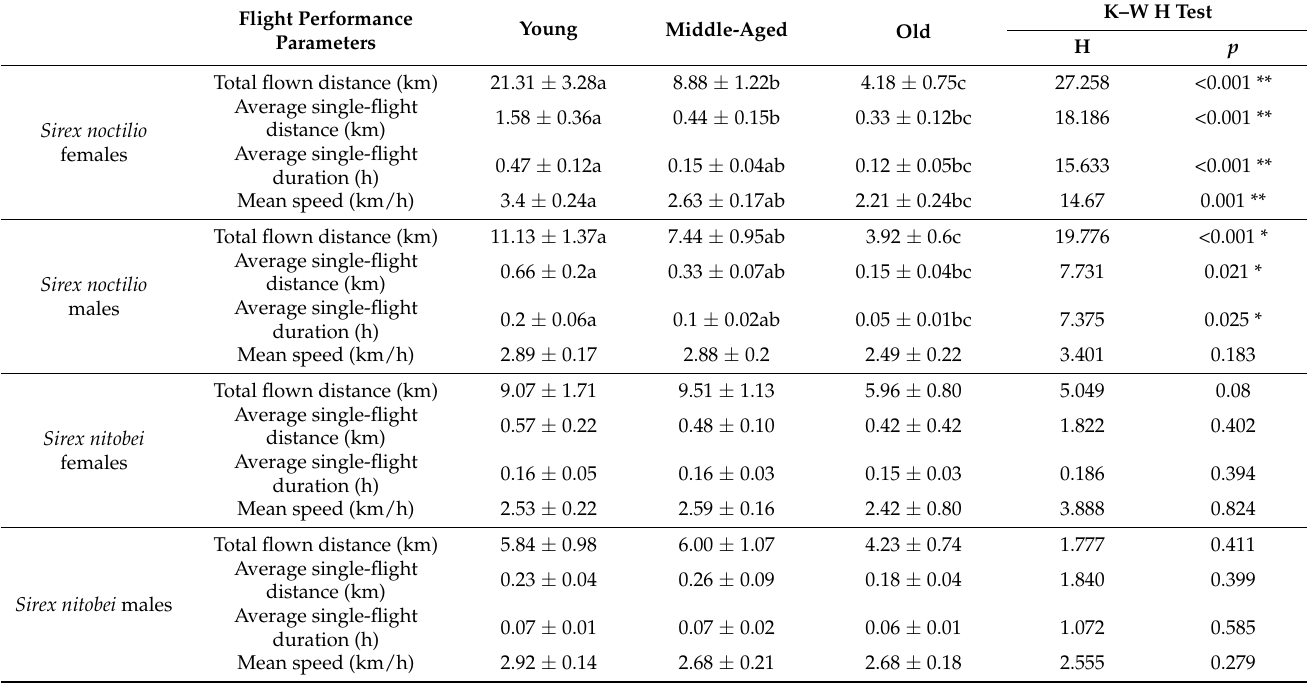
Table A1. Flight performance parameters of Sirex noctilio and Sirex nitobei in different age cohorts. Flight Performance Parameters